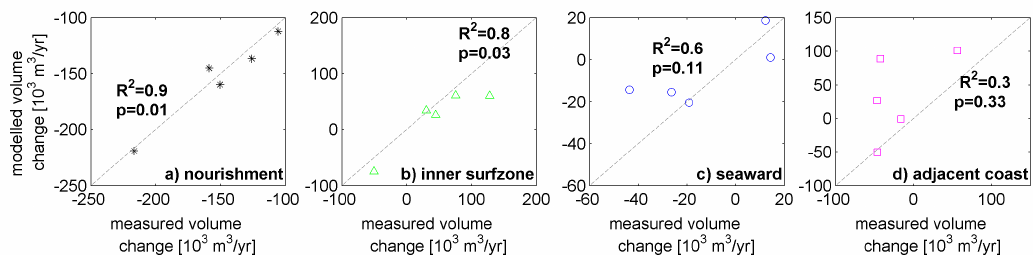
Figure 16. Modelled and observed rate of change of the volume of predefined regions of the Ter Heijde’97, Katwijk’98, Noordwijk’98, Noordwijkerhout’02 and Egmond’99 shoreface nourishments. Four different regions are shown: (1) the initial nourishment area, (2) inner surfzone, (3) seaward of the nourishment and (4) the adjacent coast. A linear fit and coefficient of determination ( R 2 ) and probability value ( p -value) are